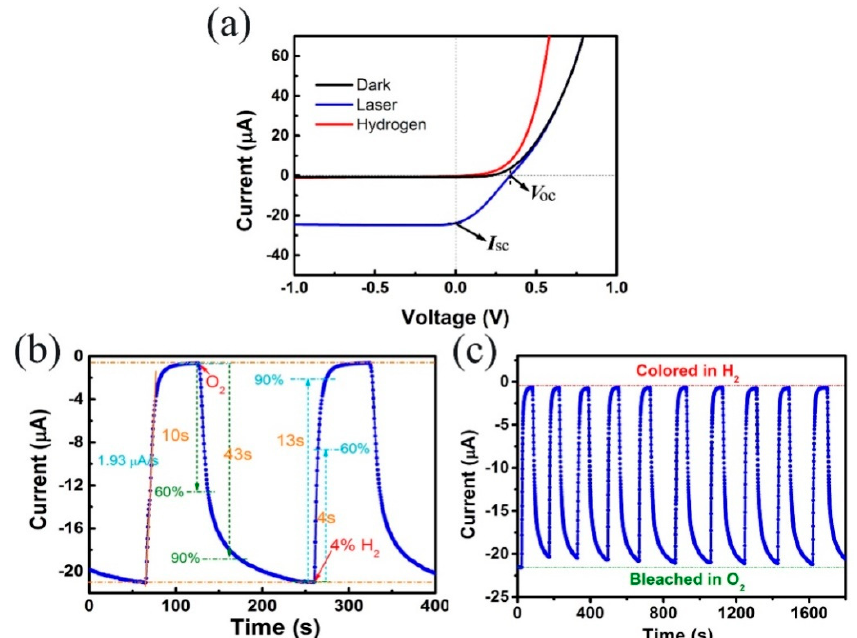
Figure 8. Tandem gasochromic-Pd-WO 3 /graphene/Si device for optoelectronic hydrogen sensors. ( a ) I-V curves of the device in darkness and under 10 mW laser illumination, with and without H 2 ; ( b ) Response of the device to the 4 vol% H 2 /Ar; ( c ) Cyclic performance of the device [122] . Copyright (2020), with permission from Elsevier.